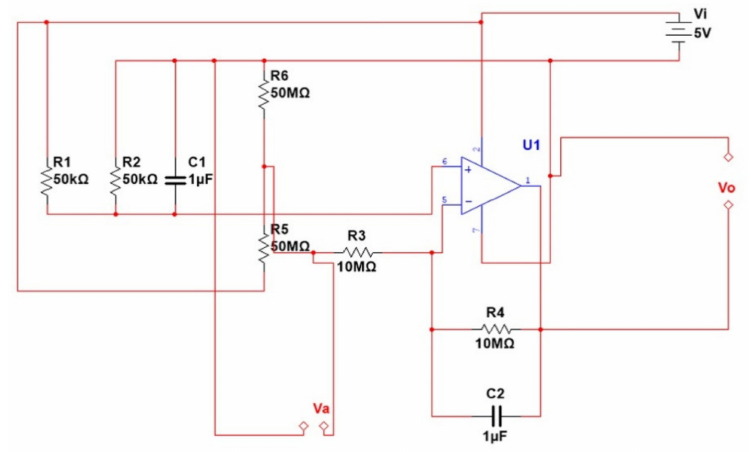
Figure 2. Implemented GSR circuit.